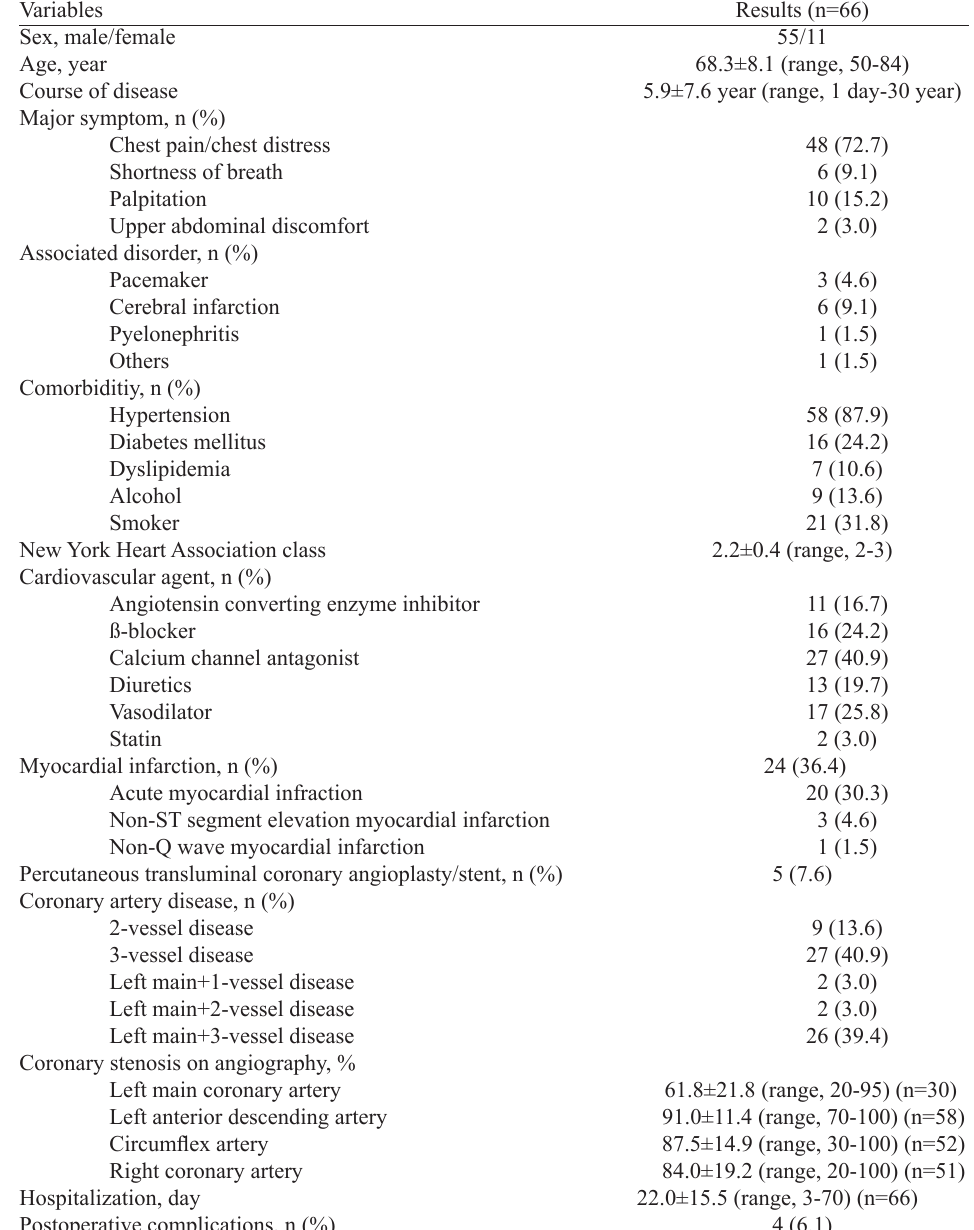
Table 1. Patient demographics.